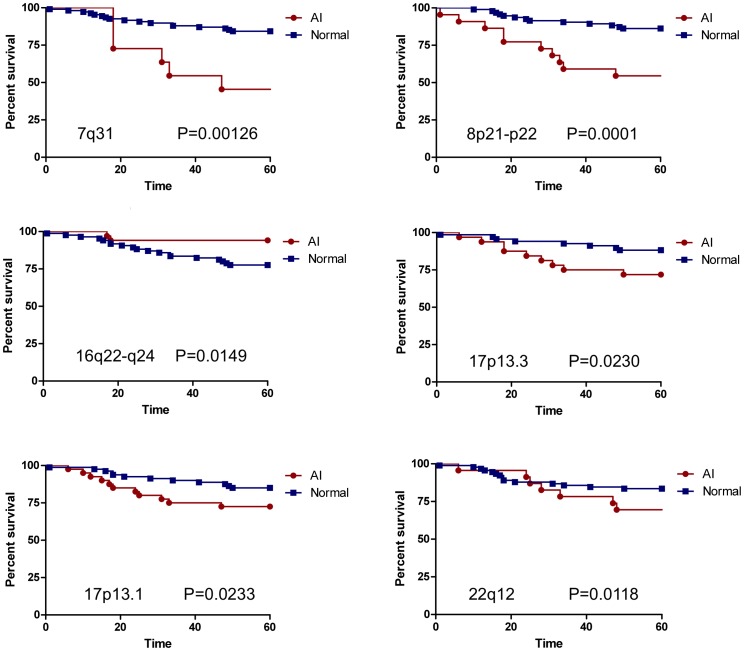
Survival curves of six chromosomal regions associated with significant differences in survival between patients with and without AI.Red circles = tumors demonstrating AI, blue squares = tumors without detectable AI. For chromosome 16q22–q24, those patients with AI at chromosome 16q22–q24 have significantly better survival than those with retention of chromosome 16q22–q24.